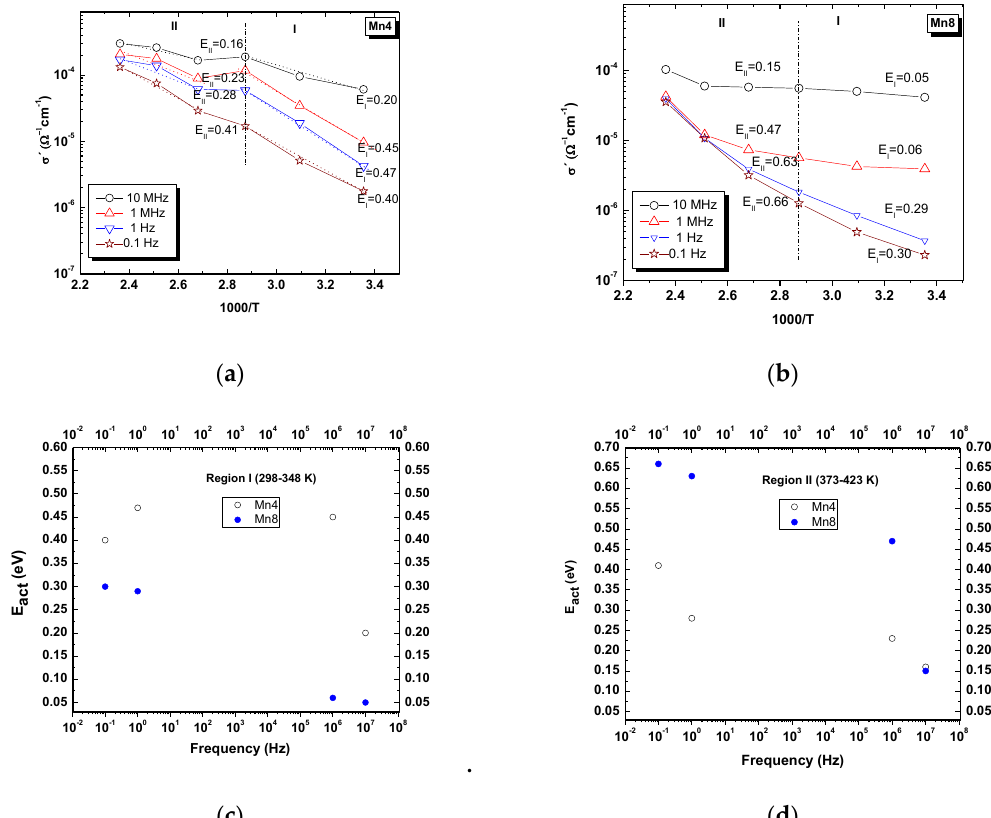
Figure 8. Arrhenius plot of the real component of the complex conductivity.( a ) Mn4, ( b ) Mn8, ( c ) comparison of the activation energy between 298 to 348 K, ( d ) comparison of the activation energy between 373–423 K.